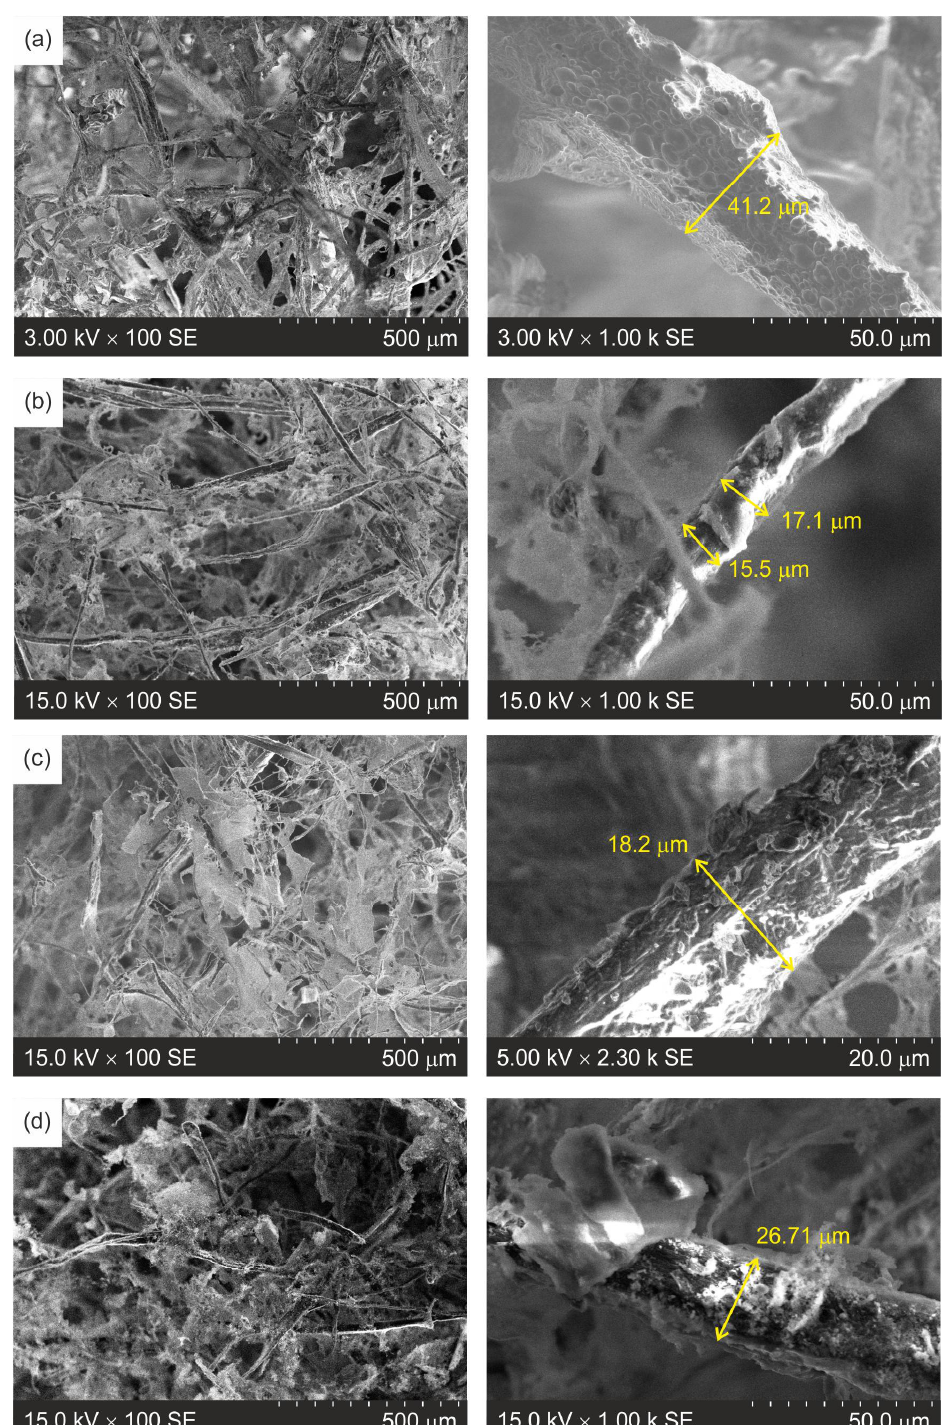
Figure 4. Microscopic structure of the aerogels with a different cross-linkers (left photo shows the overview before modification with MTMS and the right photo show a detail in 10-fold-higher magnification than the left photo after modification with MTMS): ( a ) polyester resin (control), ( b ) cellulose acetate, ( c ) starch and ( d ) starch–cellulose acetate.